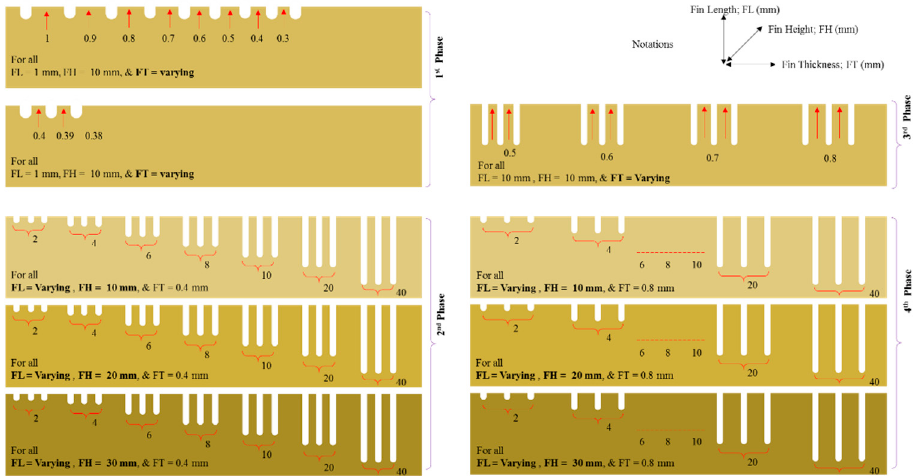
Figure 3. Layout of high aspect ratio thin structures with respect to phased experimentation (dimensions are not to scale).